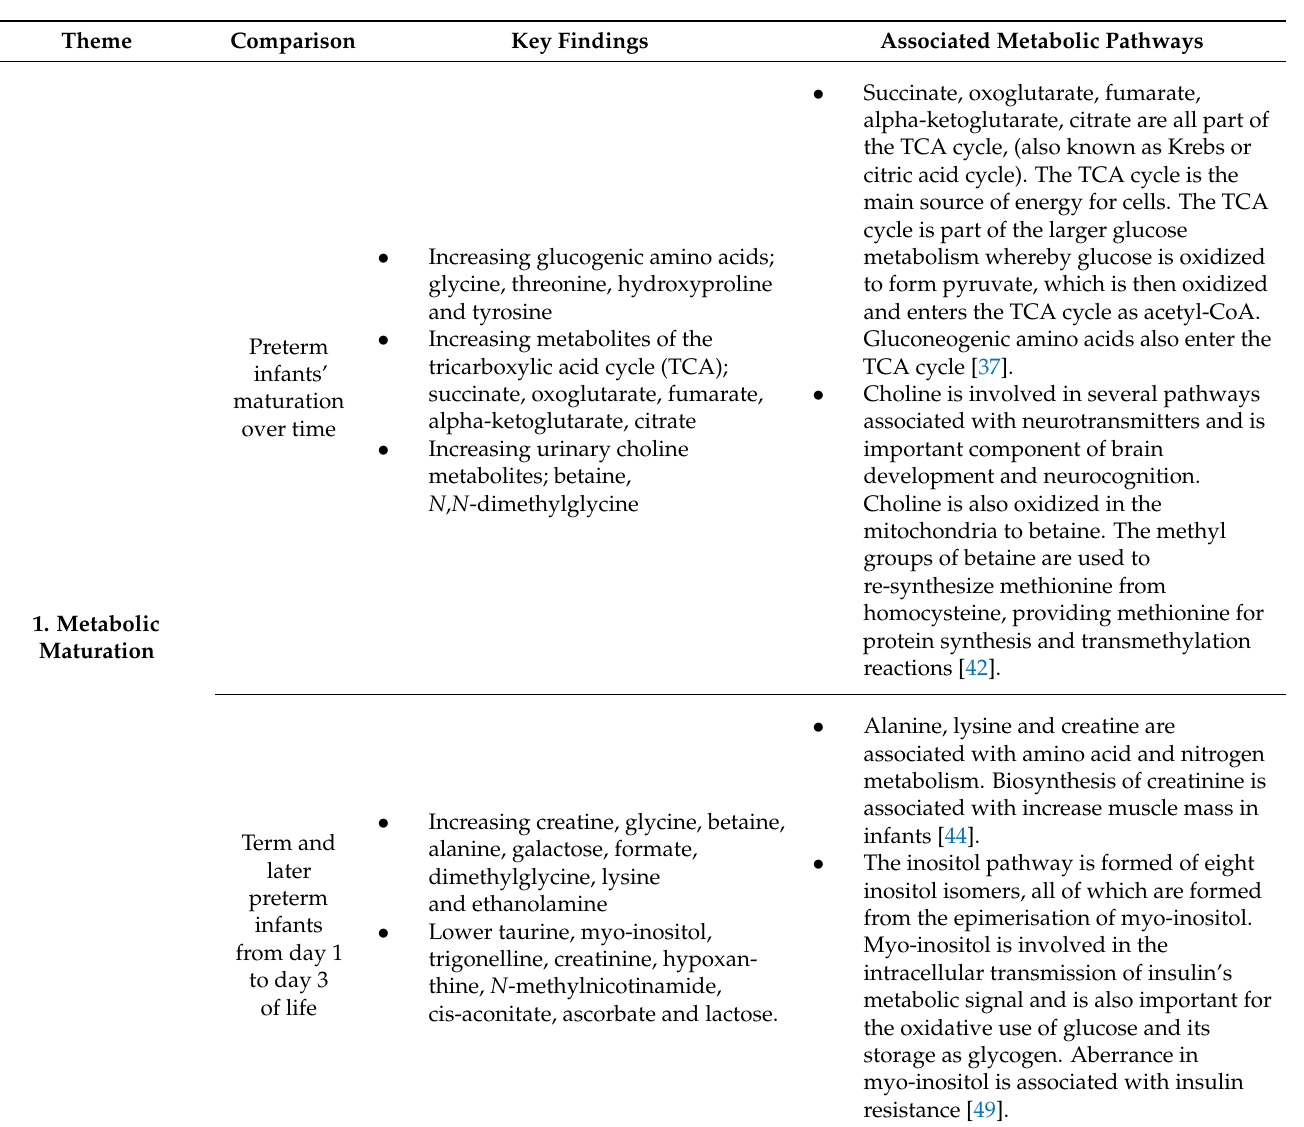
Table 2. Content analysis of metabolite maturation in infants born